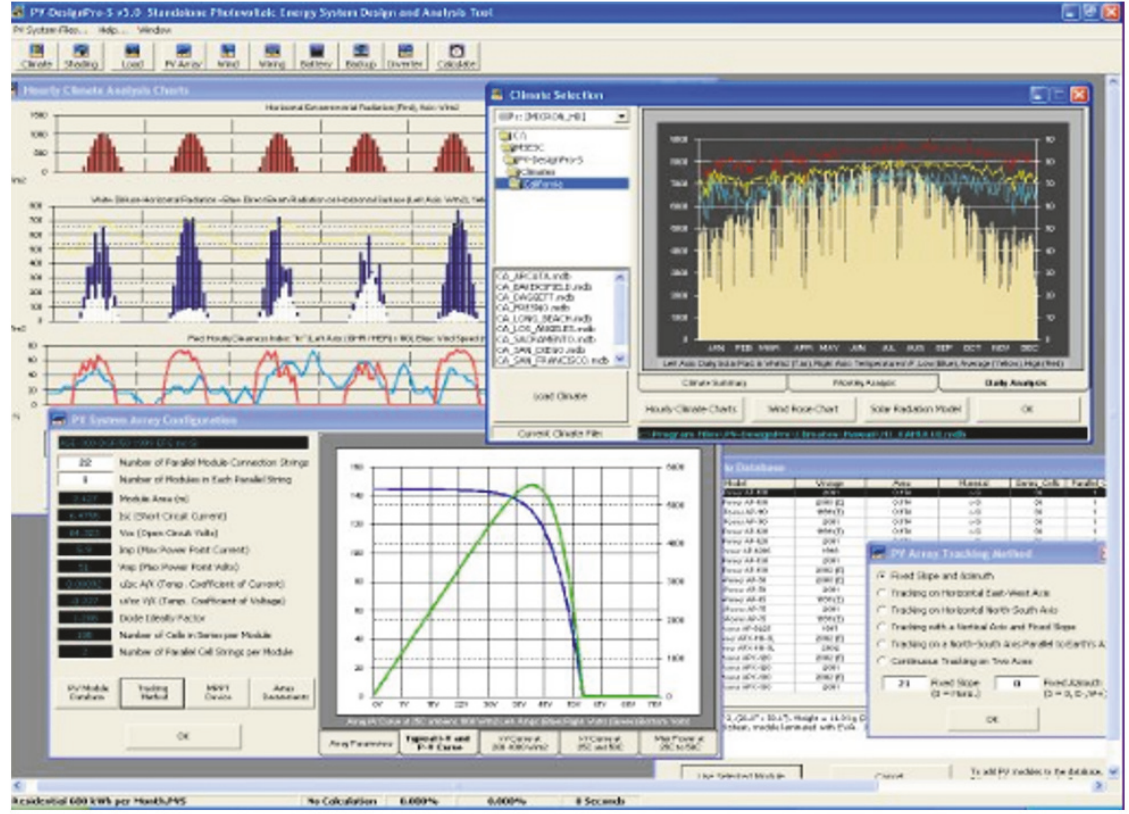
Figure 5: PV-Design Pro output sample (Source: